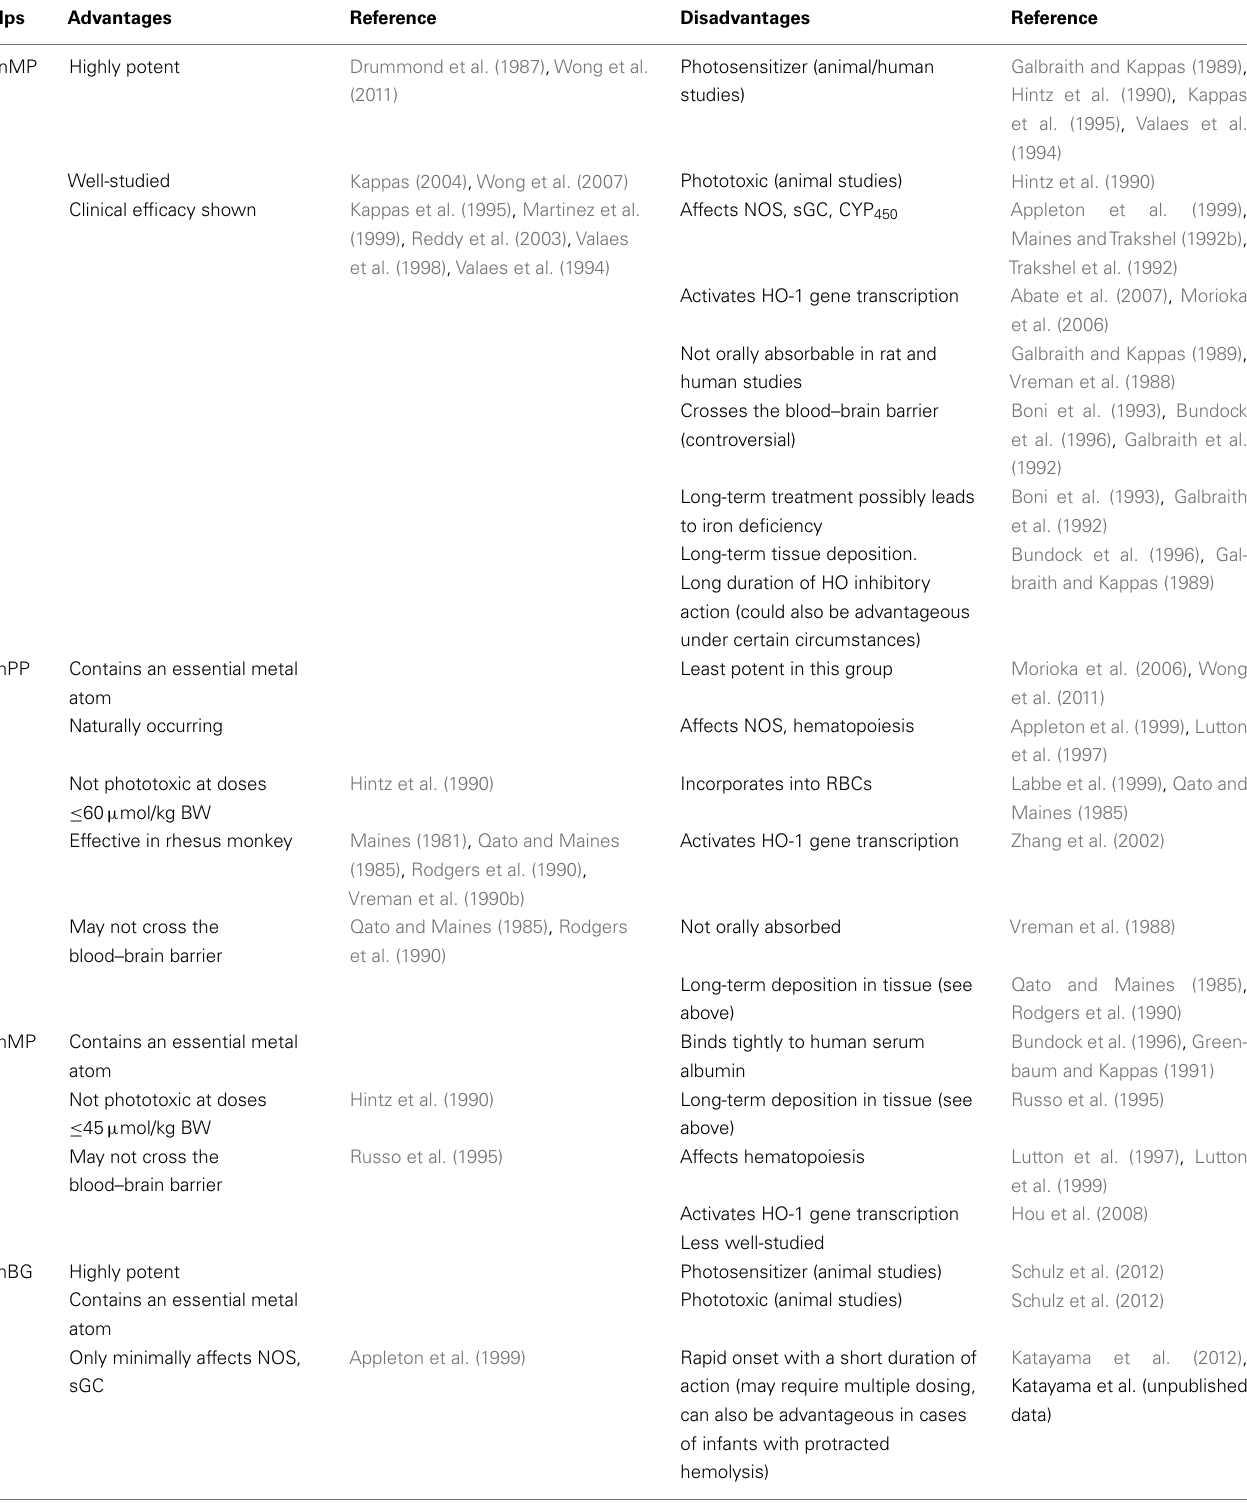
Table 2 | Major advantages and disadvantages of promising